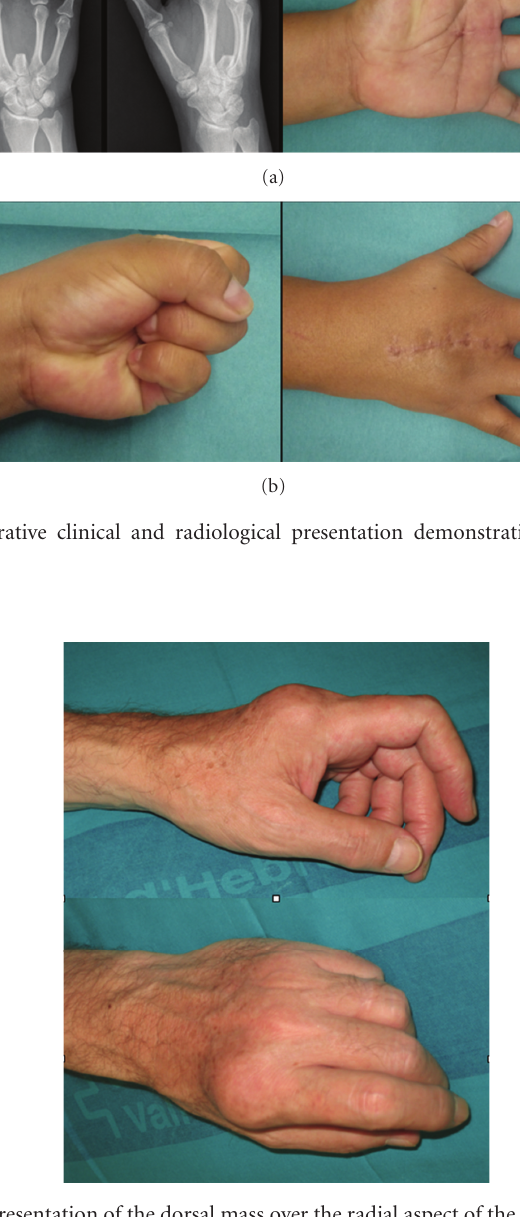
Figure 12: Clinical presentation of the dorsal mass over the radial aspect of the distal second